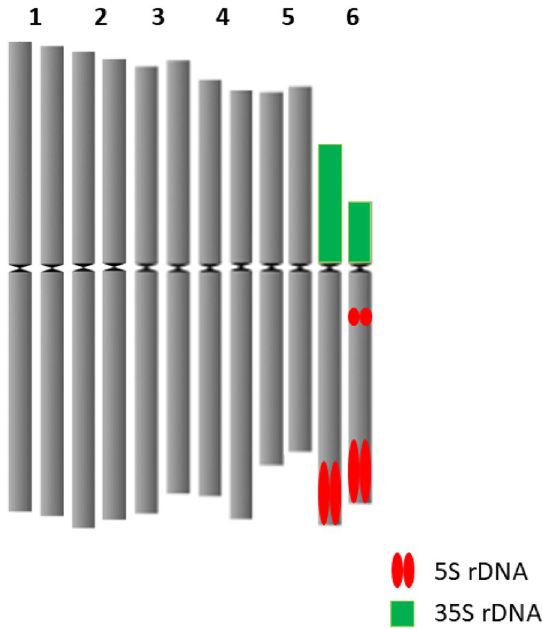
Fig. 7 Idiogram of Plantago